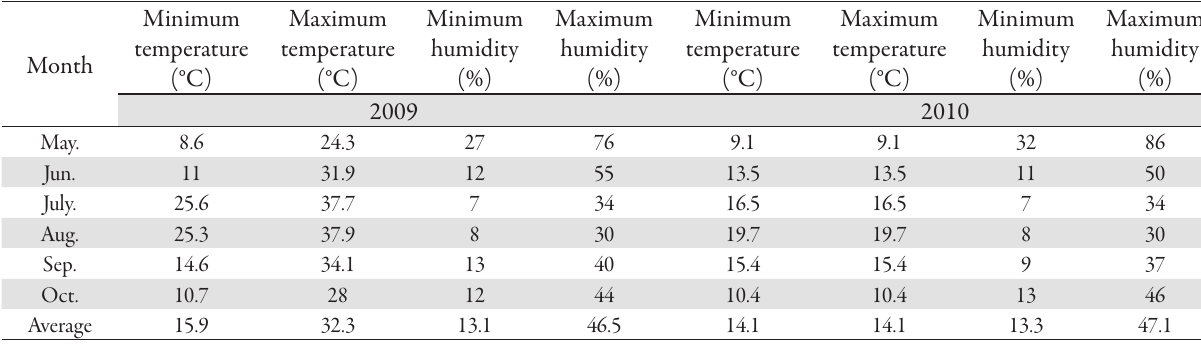
Tab. 1. Climate characteristics of experimental location